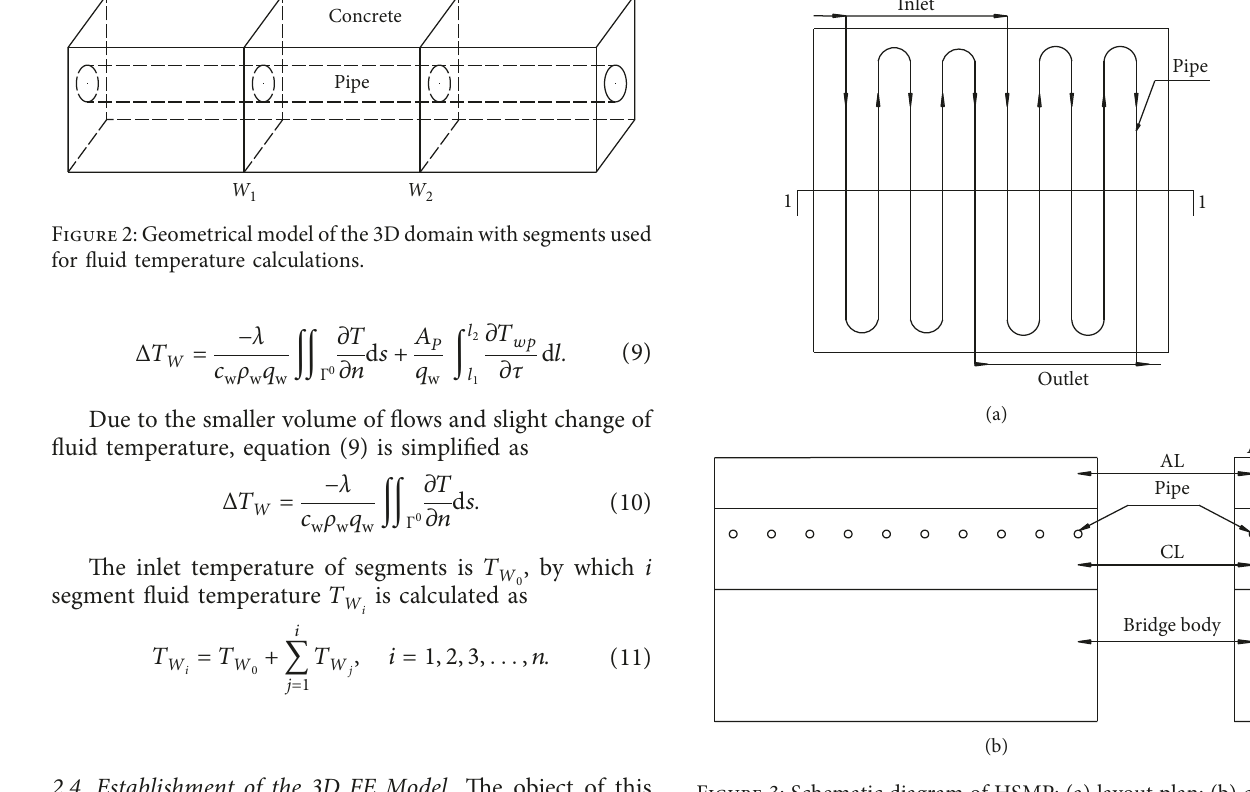
Figure 3: Schematic diagram of HSMP: (a) layout plan; (b) cross- sectional view of Section 1.